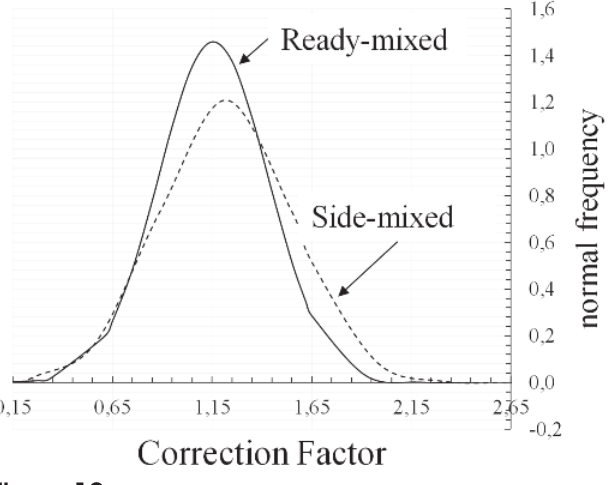
Figure 10 Frequency distribution for the correction factors of all ready-mixed and side-mixed